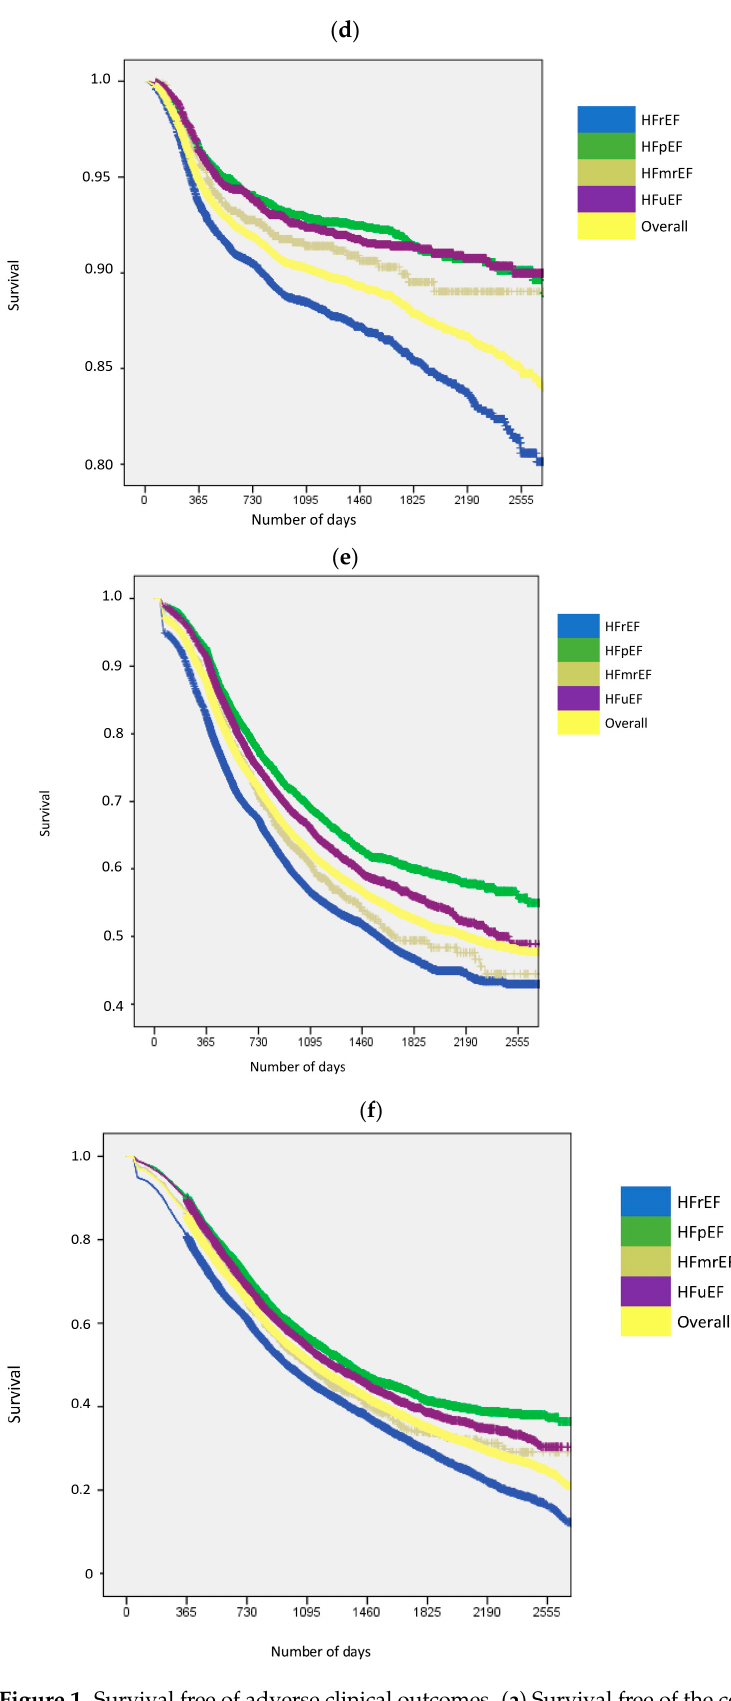
Figure 1. Survival free of adverse clinical outcomes. ( a ) Survival free of the composite MACE out- come: overall and by EF subgroup. ( b ) Survival free of stroke: overall and by EF subgroup. ( c ) Sur- vival free of all-cause mortality: overall and by EF subgroup. ( d ) Survival free of myocardial infarc- tion: overall and by EF subgroup. ( e ) Survival free of HF hospitalization: overall and by EF sub- group. ( f ) Survival free of HF hospitalization and all-cause mortality: overall and by EF subgroup. Abbreviations: EF = ejection fraction; HF = heart failure; HFmrEF = heart failure with a mildly re- duced ejection fraction; HFpEF = heart Failure with a preserved ejection fraction; HFrEF = heart failure with a reduced ejection fraction; HFuEF = heart failure with an unknown ejection fraction; MACE = major adverse cardiovascular event. The factors associated with the risk of the composite outcome hospitalization of HF and all-cause mortality in the overall HF cohort are shown in Figure 2. HFrEF (vs. HFmrEF or HFpEF), an increased age, the male sex, prior myocardial infarction, unstable angina, percutaneous or surgical revascularization, stroke, type 2 diabetes, COPD, and the use of digoxin were associated with a higher risk of the composite outcome.